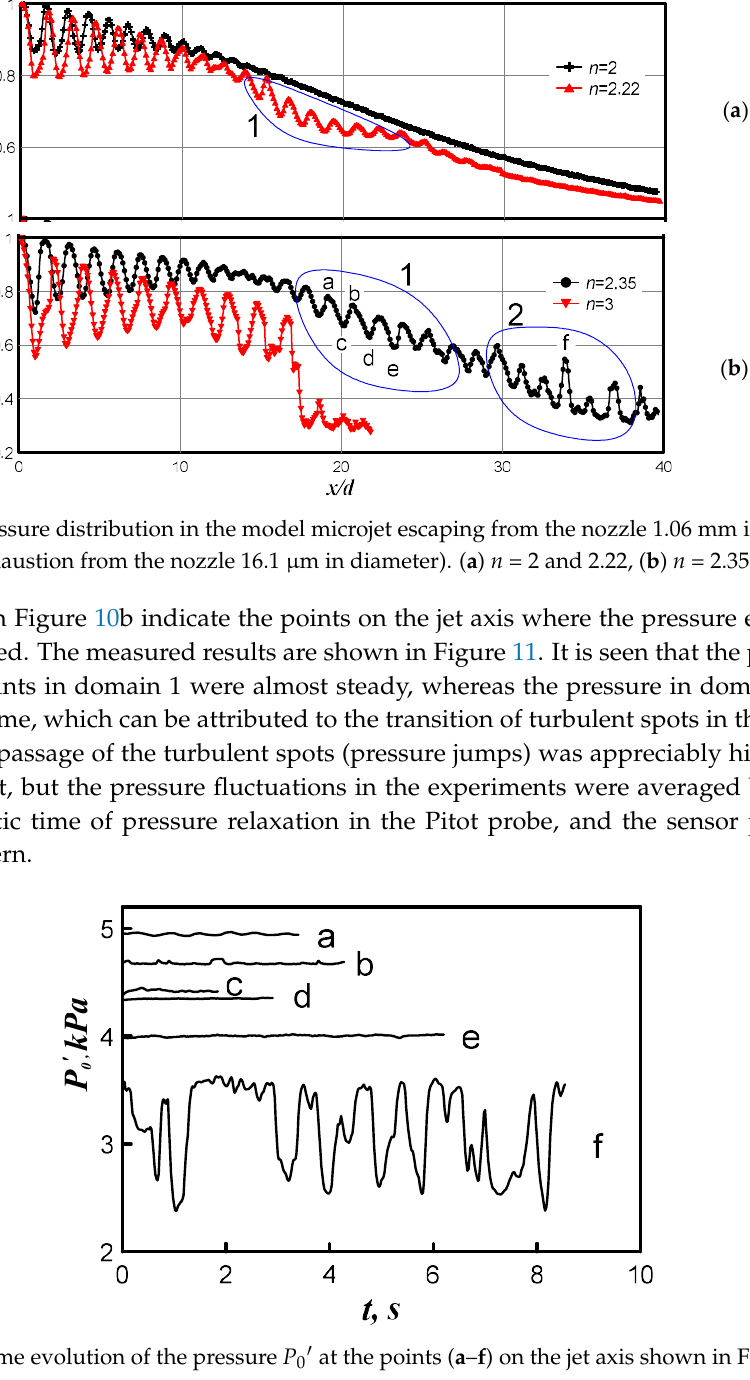
9 of 13 Figure 8. Normalized length of the supersonic core of the jet versus the ratio of the Pitot tube and nozzle diameters ( а ) and versus the ratio of the Pitot tube diameter D and nozzle diameter d multiplied by n ( b ). In the region of the jet flow transition from the supersonic to subsonic state, the velocity profile in the jet becomes significantly expanded in the transverse direction, and the Pitot tube readings become less sensitive to the Pitot tube diameter. As a result, the condition for the Pitot tube diameter with respect to the nozzle diameter with 3% error is defined as D /( dn ) ≤ 0.5. 4.2. Effect of Jet Flow Unsteadiness on Pitot Tube Measurements The measurements of the Pitot pressure distributions P 0 ' ( x / d ) on the jet axis at Reynolds numbers close to the conditions of the laminar-turbulent transition in the jet revealed significant steady fluctuations of the Pitot pressure. Such variations can be observed in both real, as shown in Figure 9, and model, as shown in Figure 10, microjets. In both real and model microjets, this effect was manifested for nozzle diameters 16–26 µm in a moderate range of JPR values. As an example, Figure 9 shows the pressure distributions in real microjets escaping from the nozzles 21.4, as shown in Figure 9a, and 16.1 µm, as shown in Figure 9b, in diameter. All data in Figure 9 refer to the laminar regime of jet exhaustion, and minor pressure fluctuations were observed only in a small range of JPR values. ( a ) ( b ) Figure 9. Pressure distributions in real microjets escaping from nozzles 21.4 ( а ) and 16.1 µm in diameter ( b ). Figure 10 illustrates the emergence of pressure fluctuations with increasing JPR for the model microjet escaping from the nozzle with d = 1.06 mm (domain 1) and modeling jet exhaustion from the nozzle 16.1 µm in diameter. The measurements were performed by the Pitot tube with the diameter D = 0.4 mm. Exhaustion of the model microjet corresponds to the laminar flow regime at n = 2 and